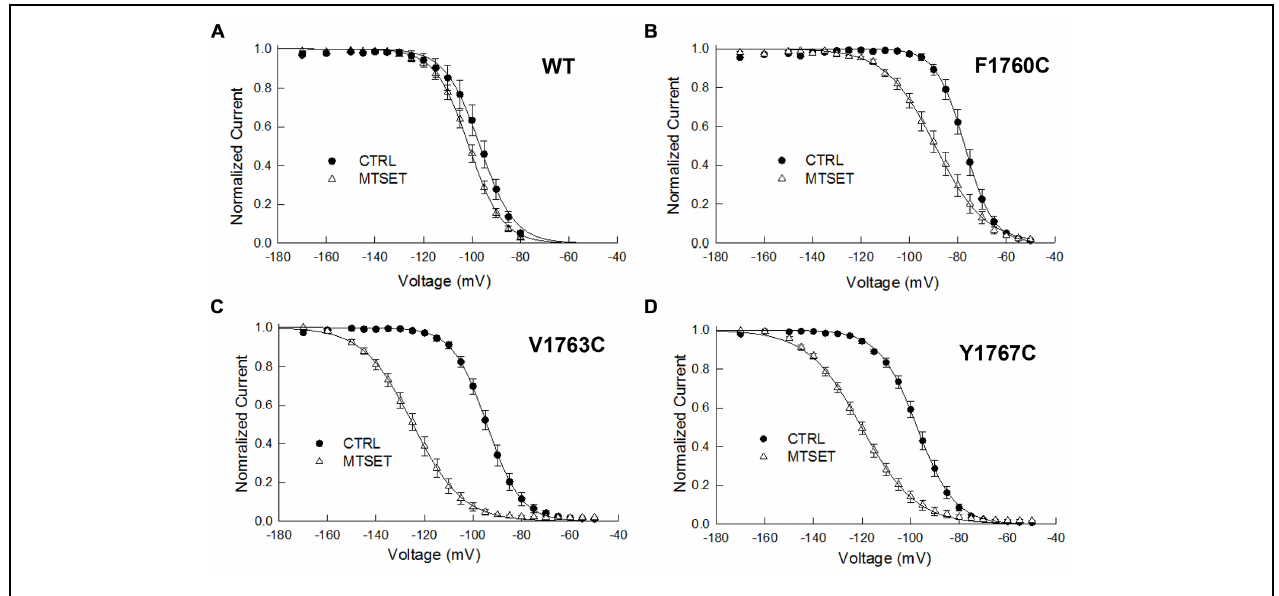
the current measured at –170 mV and plotted versus prepulse potential. Data shown are for wild-type (A) , F1760C mutant (B) , V1763C mutant (C) , and Y1767C mutant (D) channels. The smooth curves are fits to Boltzmann functions with the midpoints (V0.5) and slope factors ( k v ) listed in Table 1 .